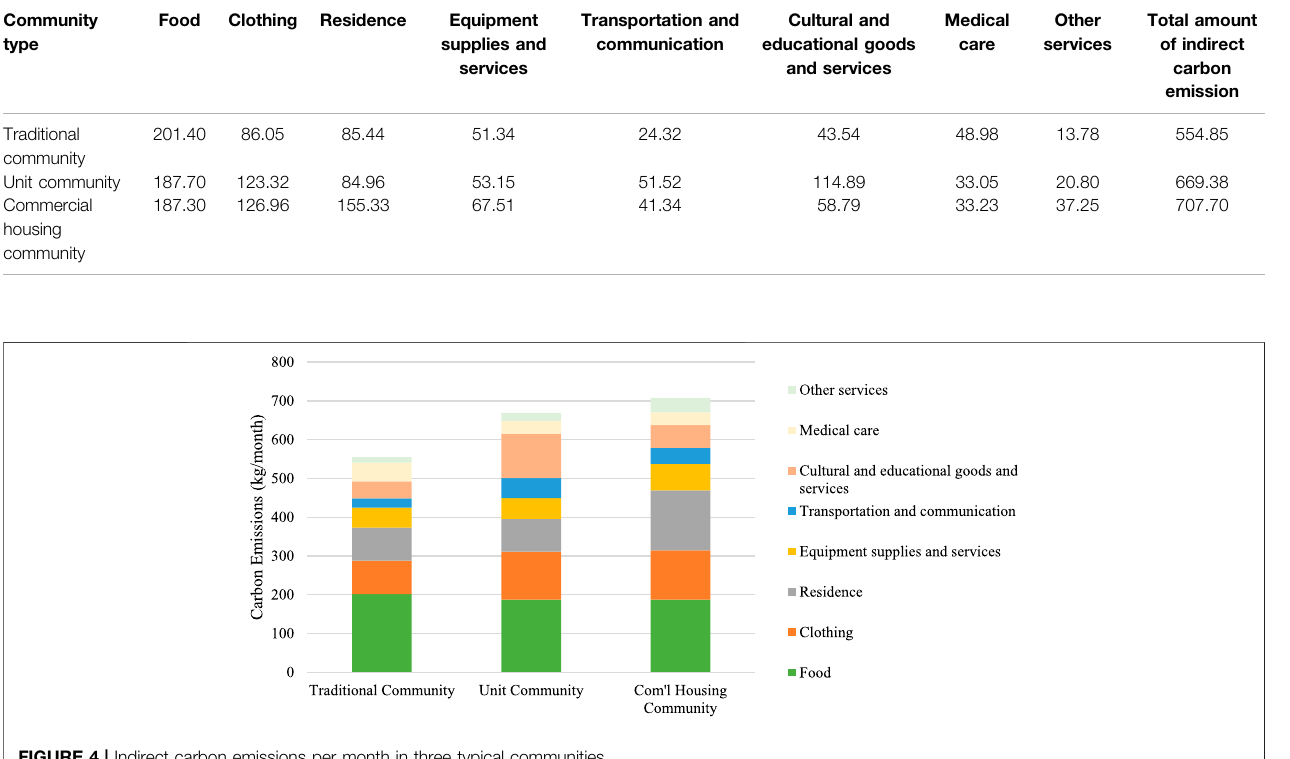
TABLE 6 | Estimation of indirect carbon emissions of three typical communities (kg/month).